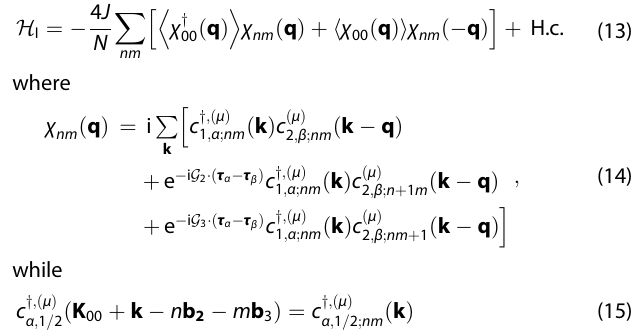
Fig. 2 Effective Hamiltonian in the large- J limit. a The bond operator r ij ¼ sgn ð p ð α Þ manifold of the g 2 terms in Eq. (11). Red (black) solid lines correspond to + ( − ) bonds. Conversely, bond con fi gurations which include NNs with sgn ð p ð α Þ Þ ≠ sgn ð p ð α Þ Þ , shown here with blue dashed lines, are not labeled by r ij bonds. These con fi gurations correspond to excited states. b A i j ground-state manifold con fi guration which minimizes the g 2 terms and which also obeys the local product constraint, equivalent to an Ising Gauss ’ s law. c g 3 terms on sites i , j fl ip four adjacent bonds resulting in an excited state. d g 6 terms change bond con fi gurations from r ij = 1 to r ij = − 1 around each plaquette and thus connect con fi gurations which belong to the Ising Gauss' Law